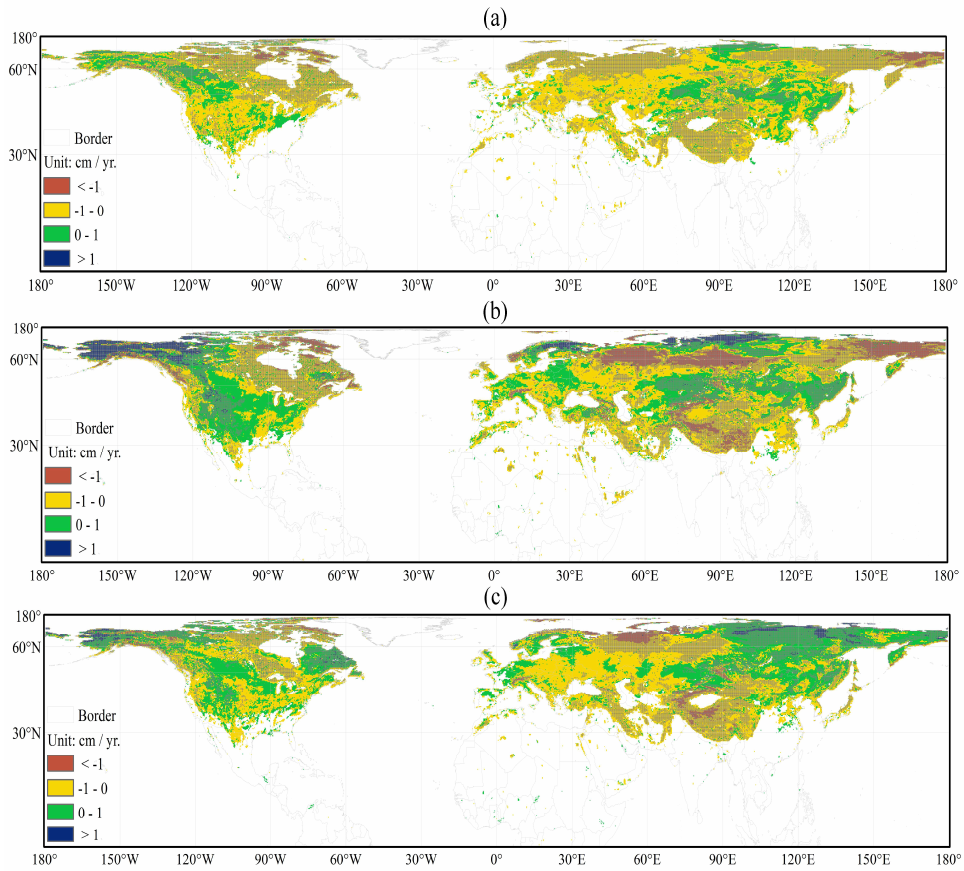
Figure 8. The variation rate pattern of the seasonal average SD over the Northern Hemisphere for three snow cover seasons, namely, autumn ( a ; September to November), winter ( b ; December to three snow cover seasons, namely, autumn (( a ); September to November), winter (( b ); December to February), and spring ( c ; March to June) from 1992–2016. The black dots in ( a – c ) indicate that the February), and spring (( c ); March to June) from 1992–2016. The black dots in ( a – c ) indicate that the changes are significant at a 95% confidence level (CL). changes are significant at a 95% confidence level